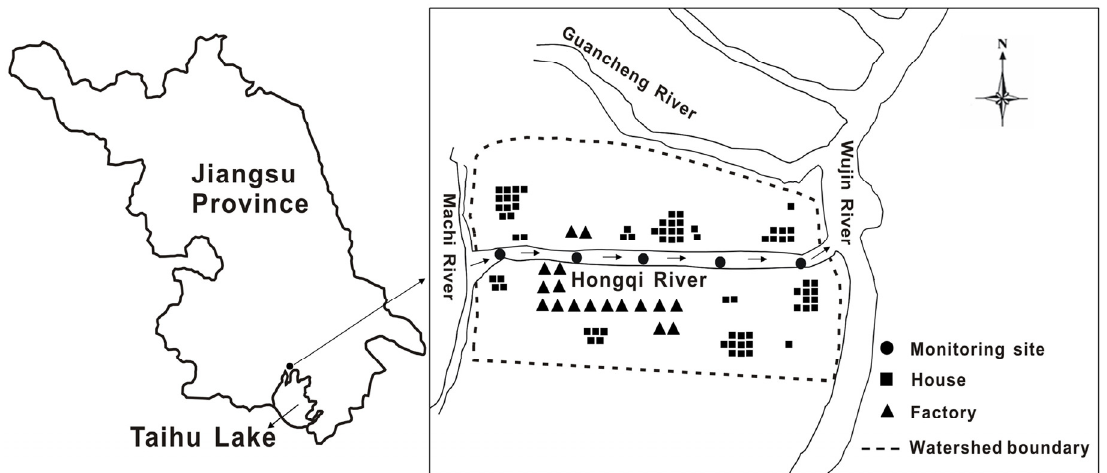
Figure 1. Study area and monitoring sites along the Hongqi River.